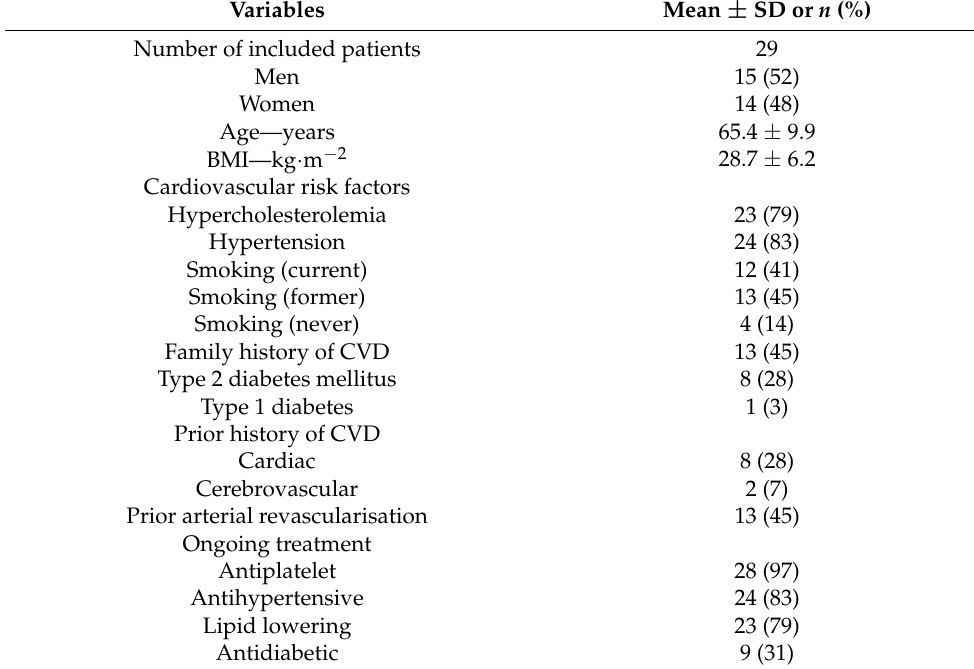
BMI: body mass index; CVD: cardiovascular